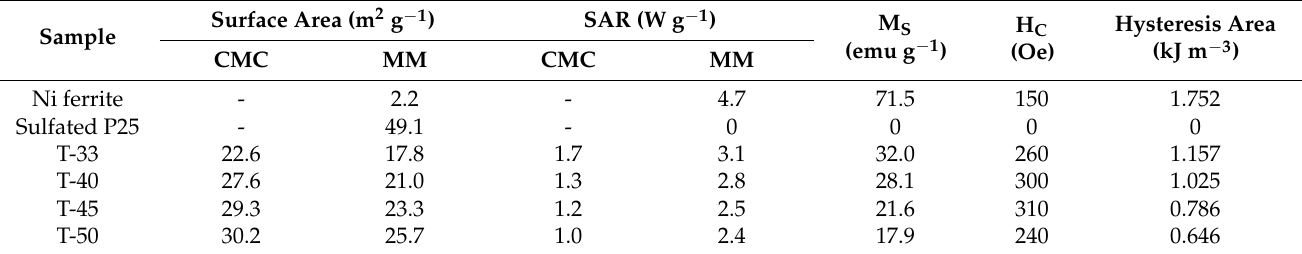
Table 1. Specific surface area and specific absorption rate of composite magnetic catalysts.